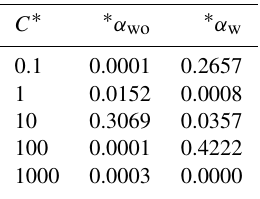
Table 4. VBS model SOA